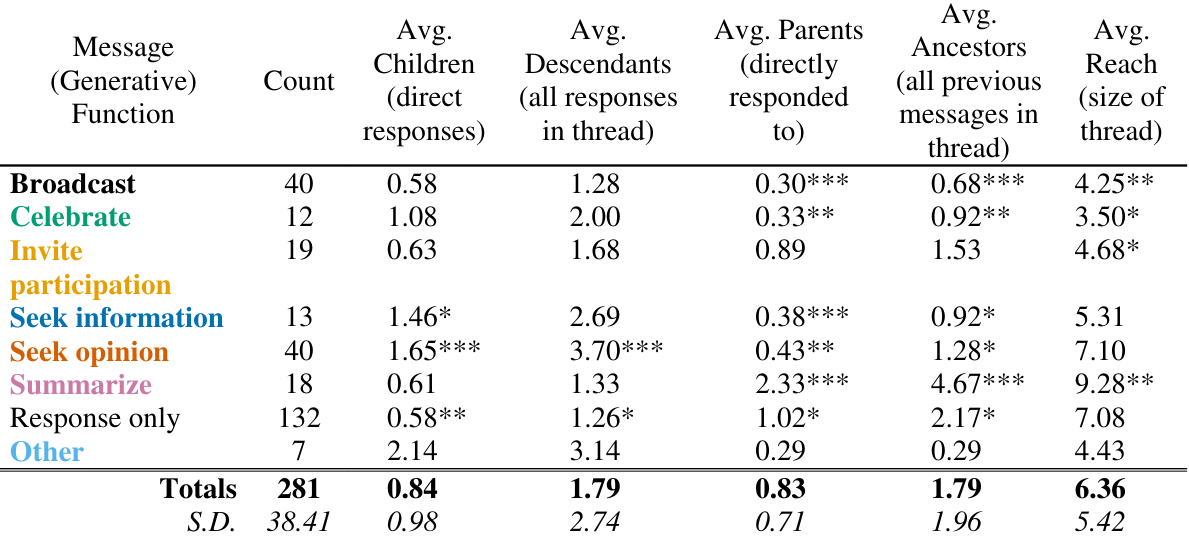
Table 1 Network metrics by message type Message